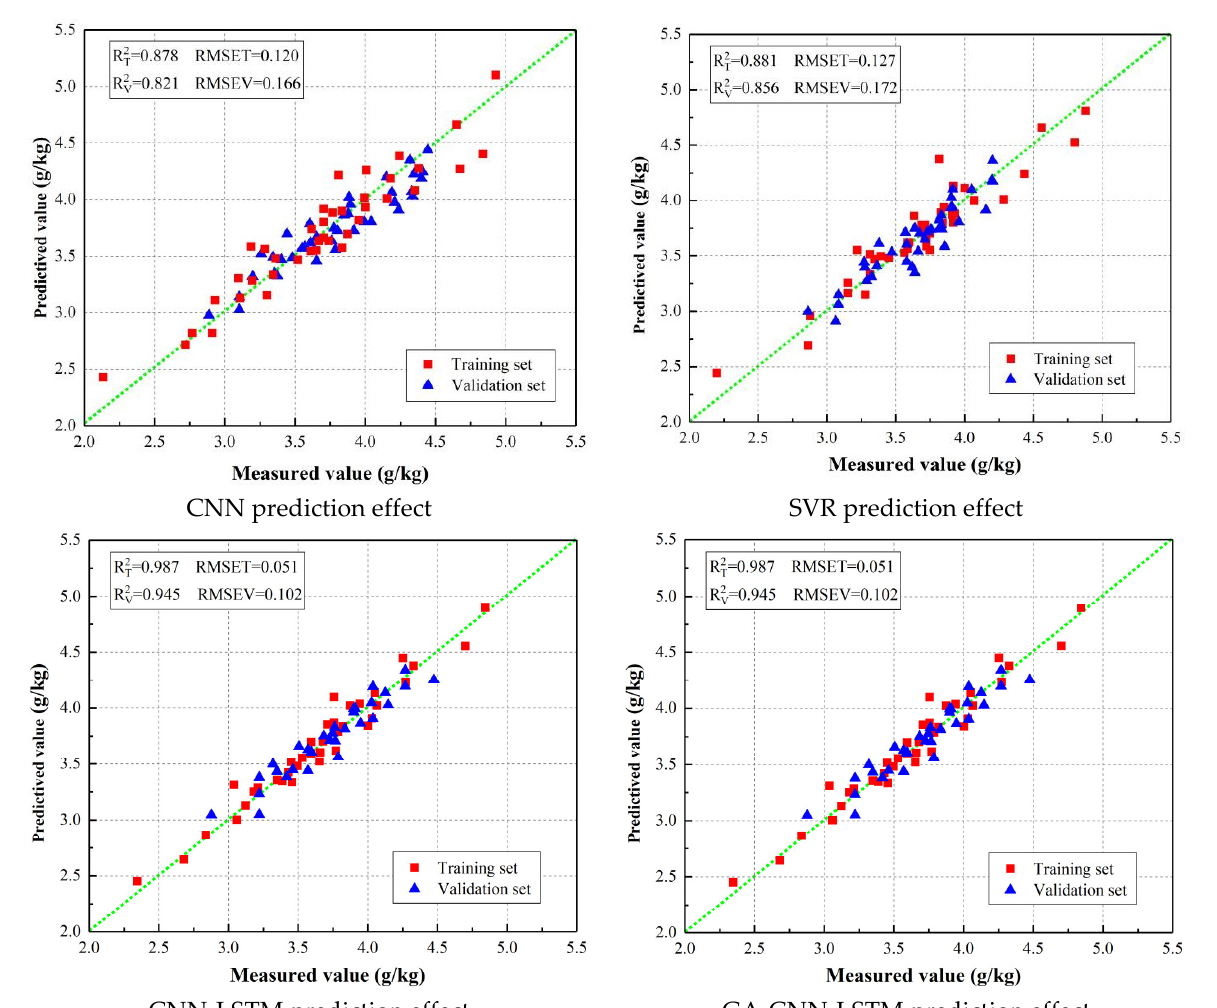
Figure 6. Measured and predicted values of soil moisture content.